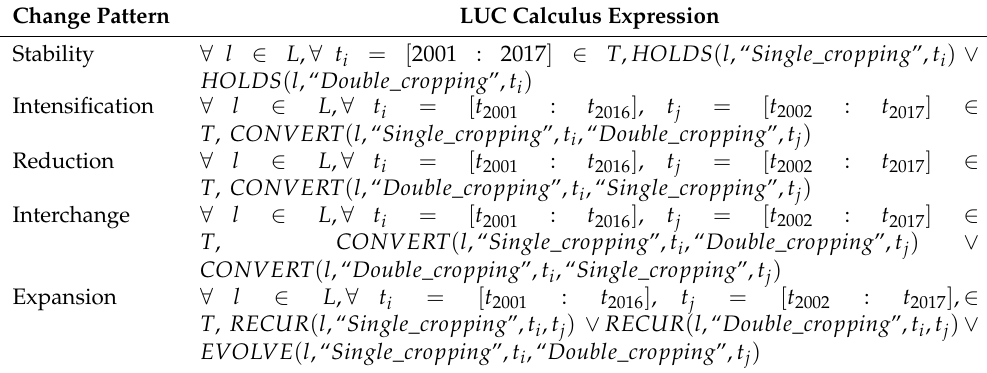
Table 2. LUC calculus predicates to express patterns of agricultural practices trajectories. Change